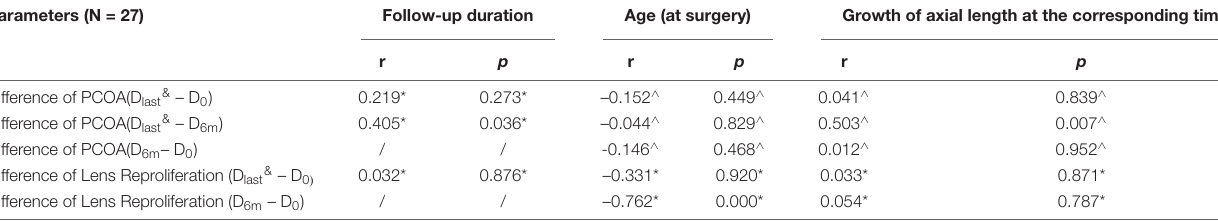
TABLE 2 | Correlation between posterior capsular opening area changes or lens reproliferation area and influential factors. Parameters (N = 27) Follow-up duration Age (at